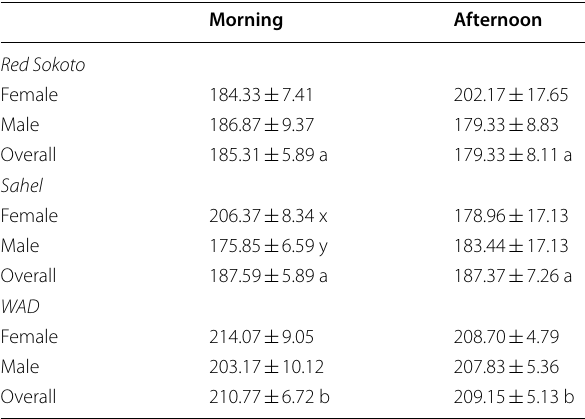
Values with a, b for the overall data between breeds and x, y for different sexes are significantly different P < 0.05